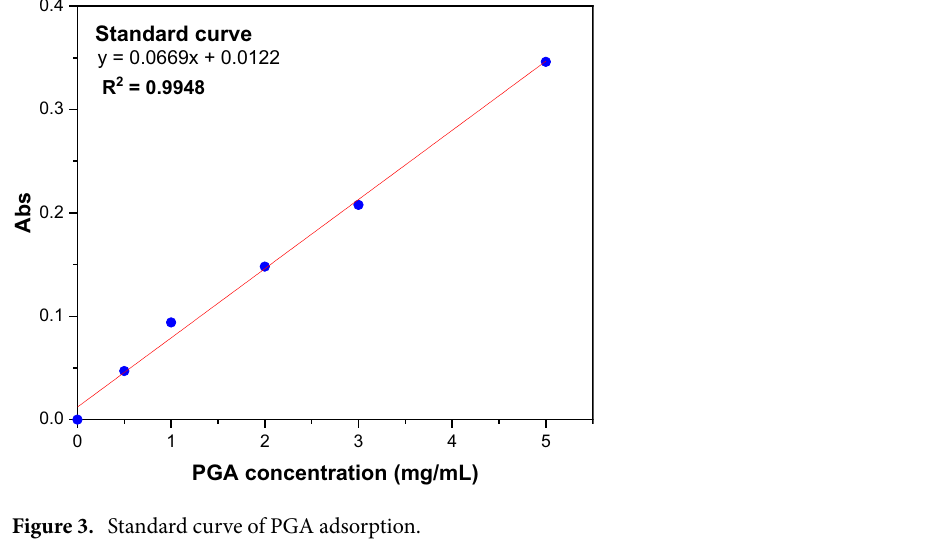
Figure 3. Standard curve of PGA